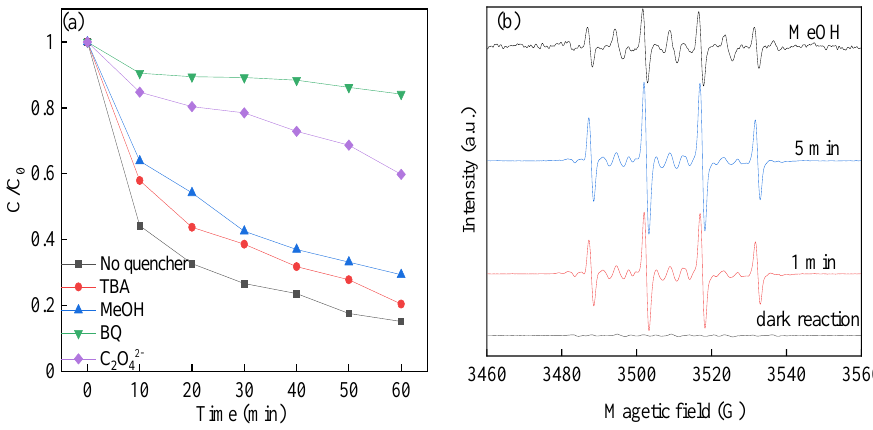
Figure 9. ( a ) Different quenching chemicals to remove RhB; ( b ) DMPO spin-trapping EPR spectra in heterogeneous SR-photo-Fenton like reaction. BQ, p-benzoquinone.